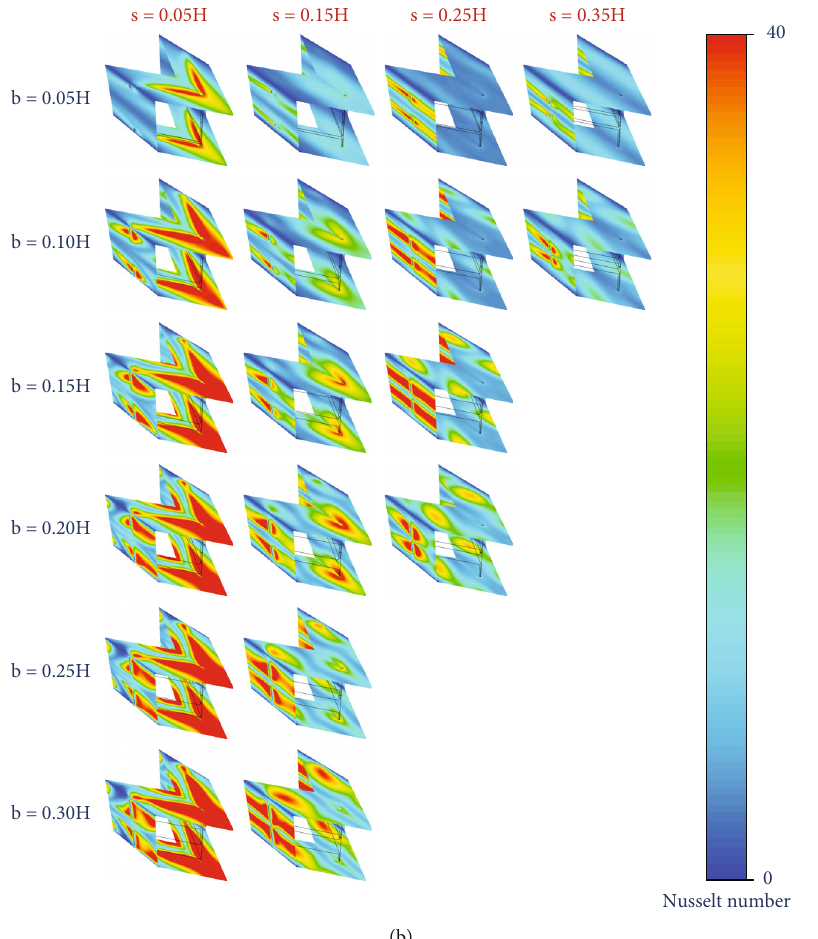
Figure 8: Local Nusselt number contours for the ba ffl ed duct with various b / H and s / H at Re = 800 of (a) VD and (b)